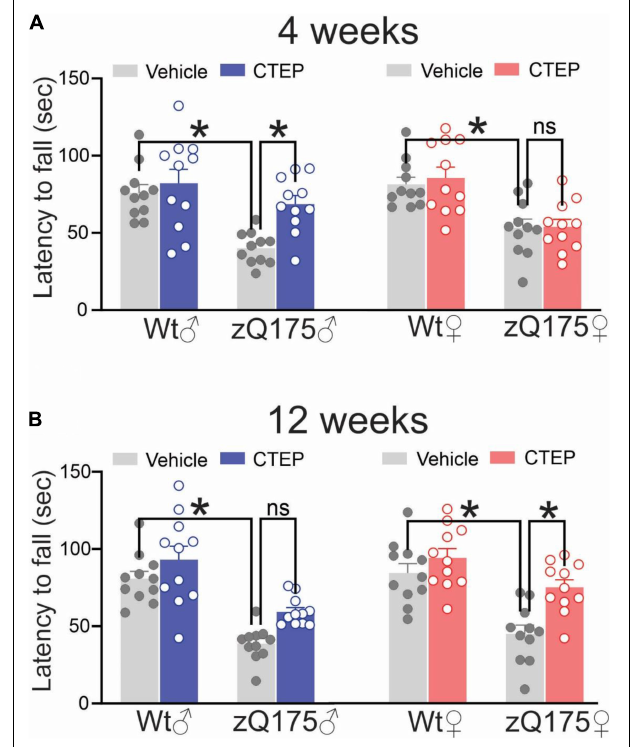
FIGURE 2 | Effect of chronic administration of CTEP on rotarod performance in male and female zQ175. Mean ± SEM of latency to fall (sec) from accelerating rotarod after 4 weeks (A) and 12 weeks (B) of treatment with either vehicle or CTEP (2 mg/kg/48 h) of 12-month-old heterozygous zQ175 (zQ175) and wild-type (Wt) male and female mice ( n = 11 for each group). * P < 0.05 by three-way analysis of variance (ANOVA) and Tukey’s multiple comparisons